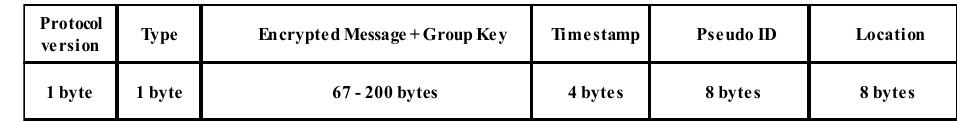
Figure 18. The format of an encrypted message for GM.